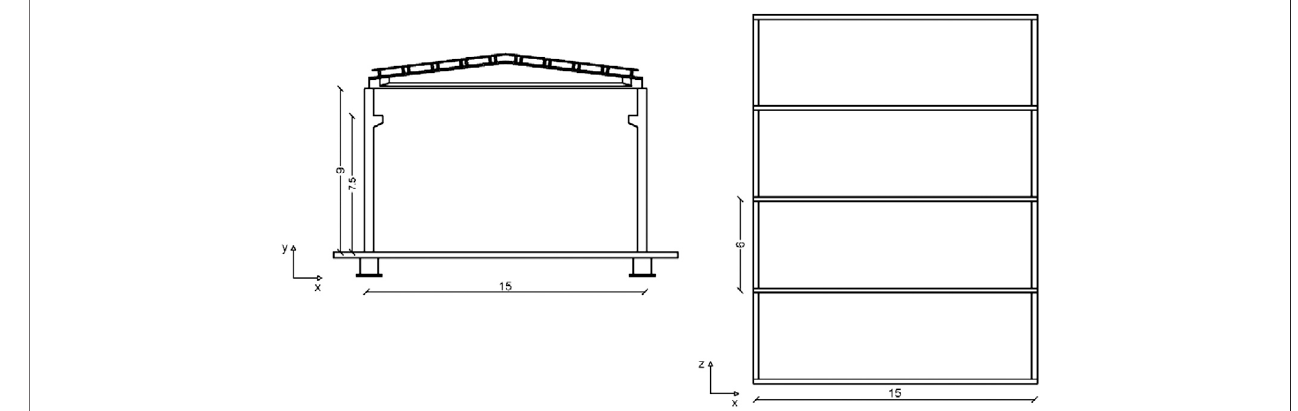
FIGURE 2 | Structural layout.